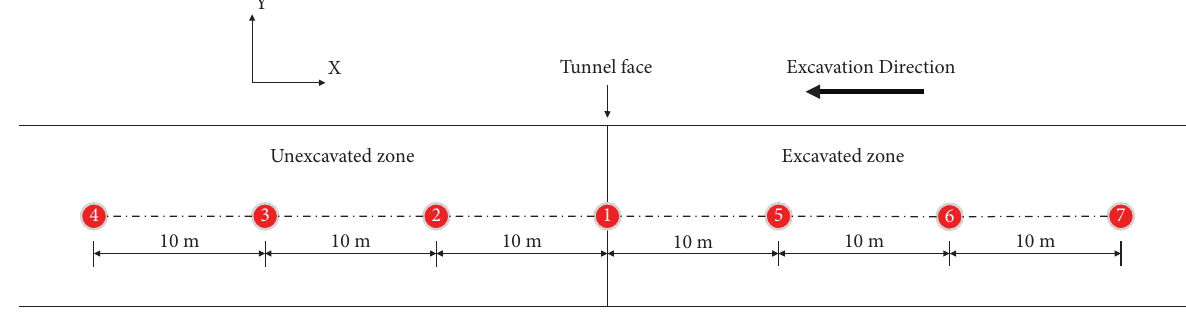
Figure 6: Schematic diagram of vibration monitoring.